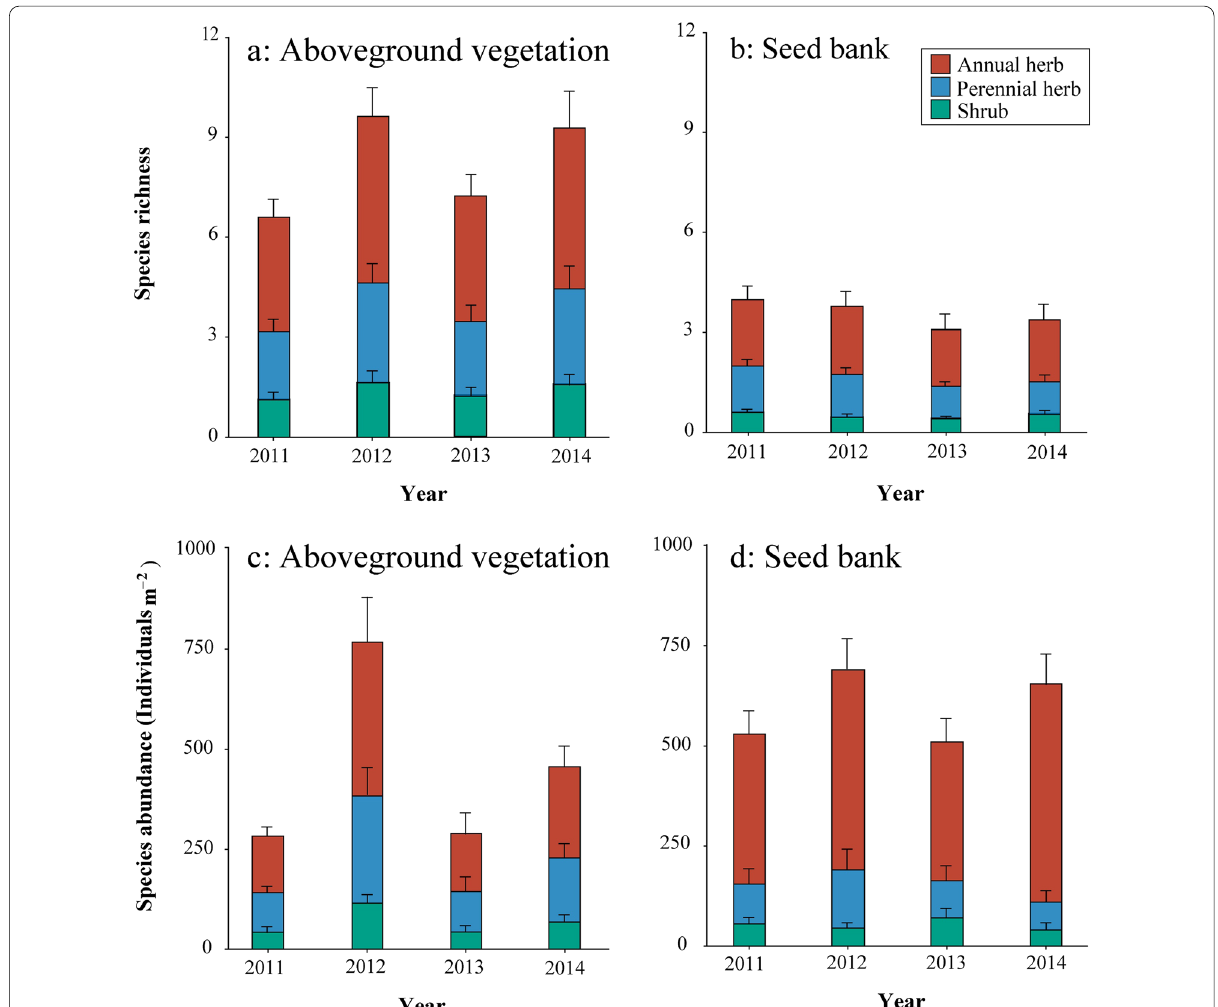
Fig. 1 Mean species richness of the aboveground vegetation a and soil seed bank b and abundance of the aboveground vegetation c and soil seed bank d per quadrat in four measured year. Values are Mean